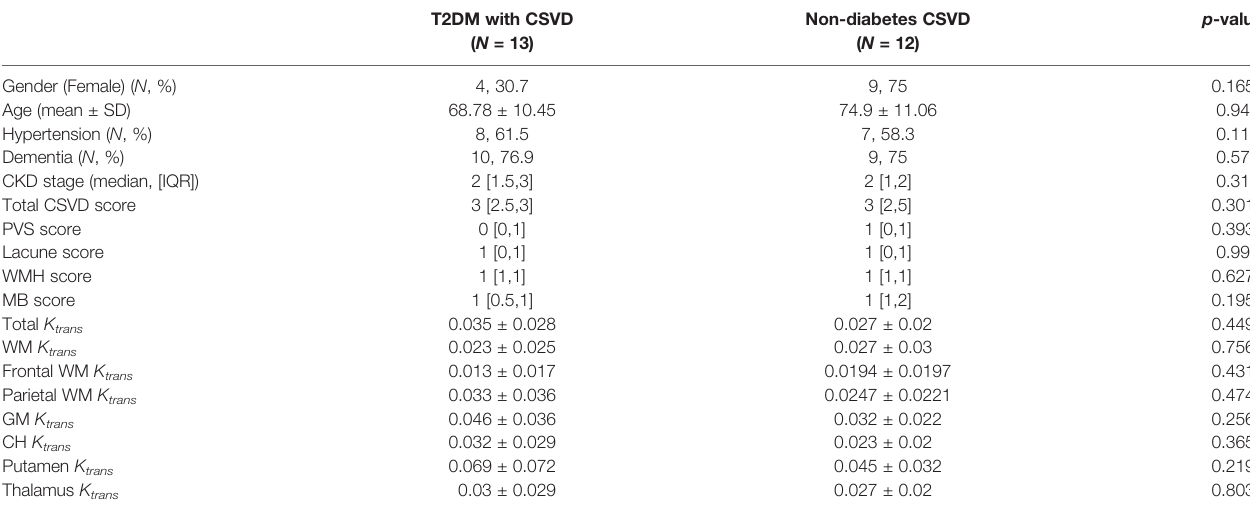
TABLE 2 | Comparisons of demographic data between patients with CSVD with and without T2DM. T2DM with CSVD Non-diabetes